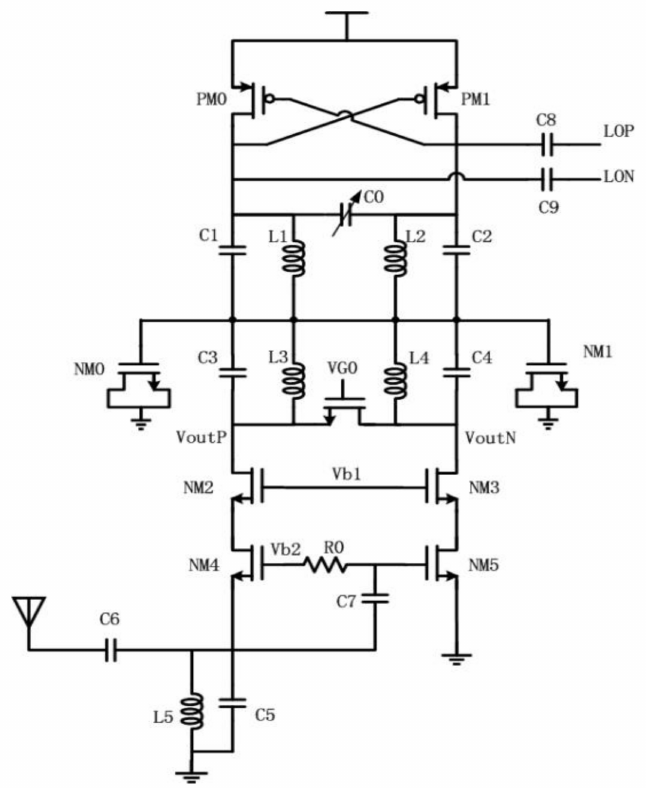
Figure 2. Circuit schematic of the current-reusing structure of the low noise amplifier (LNA) and voltage controlled oscillator